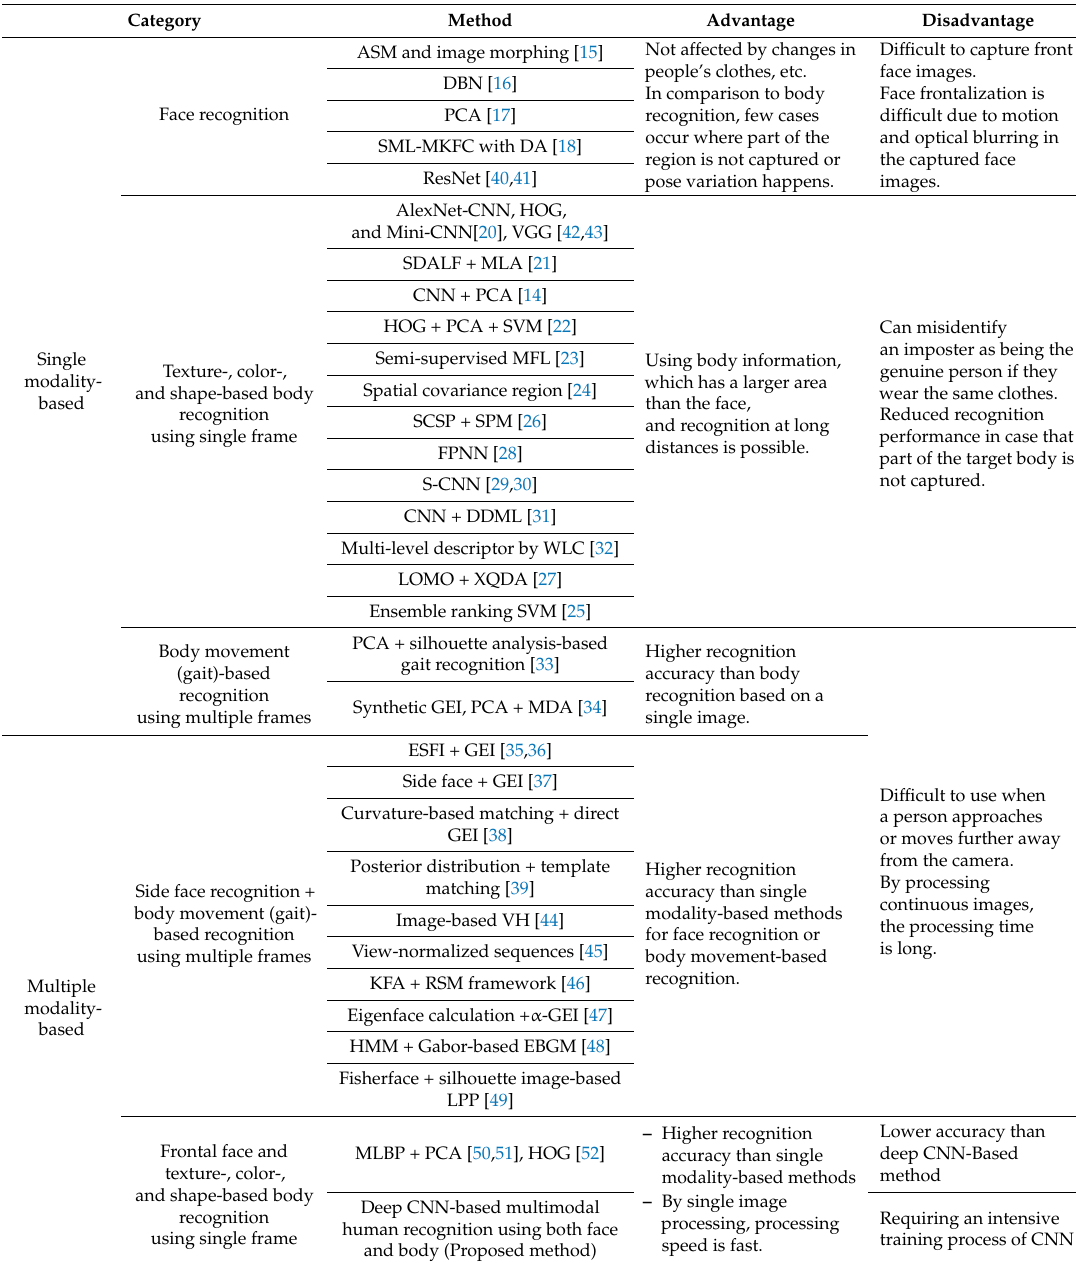
Table 1. Summary of our study and previous works on human